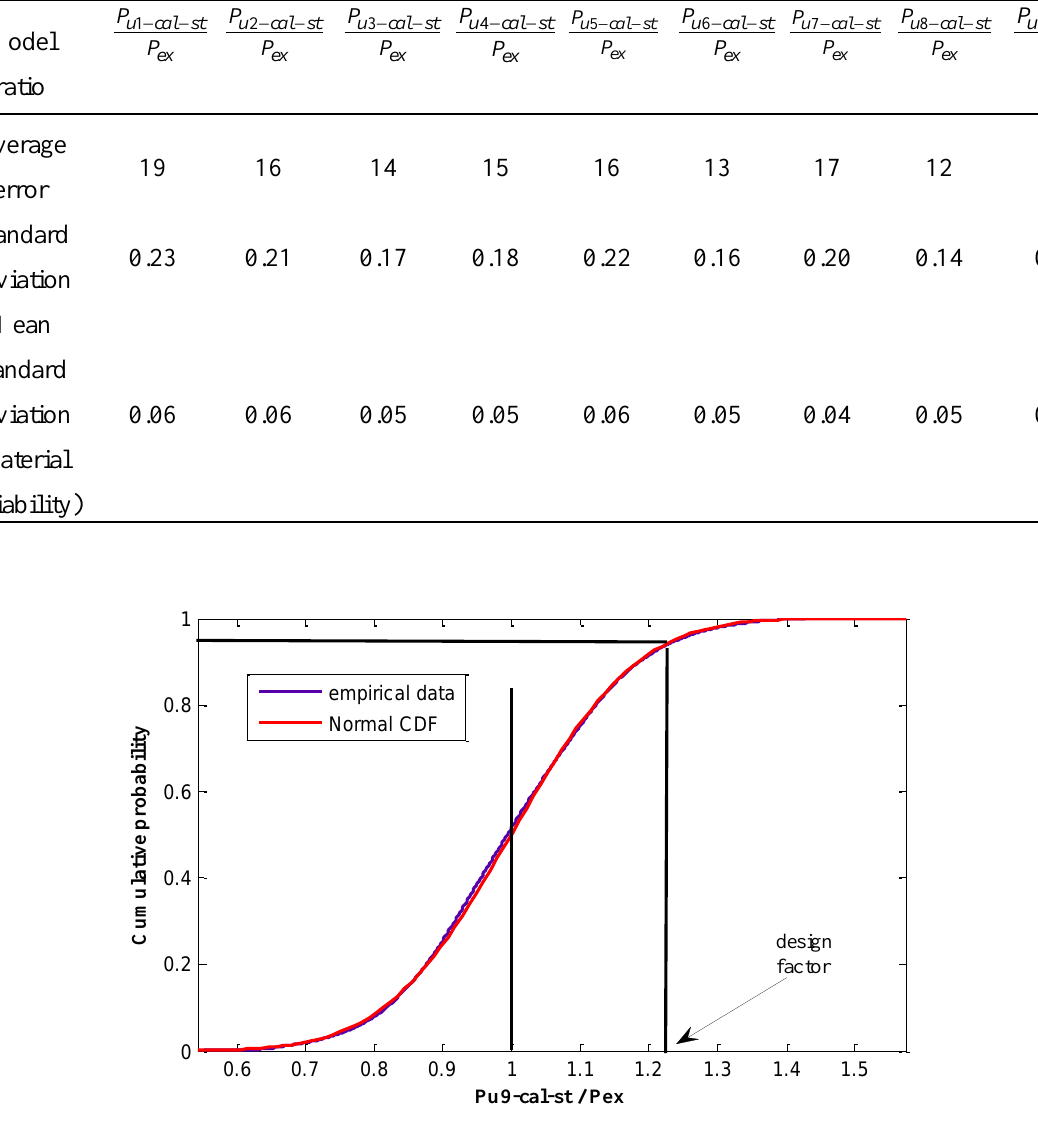
Fig. 7. Design factor for the calibrated model 9 considering uncertainties.